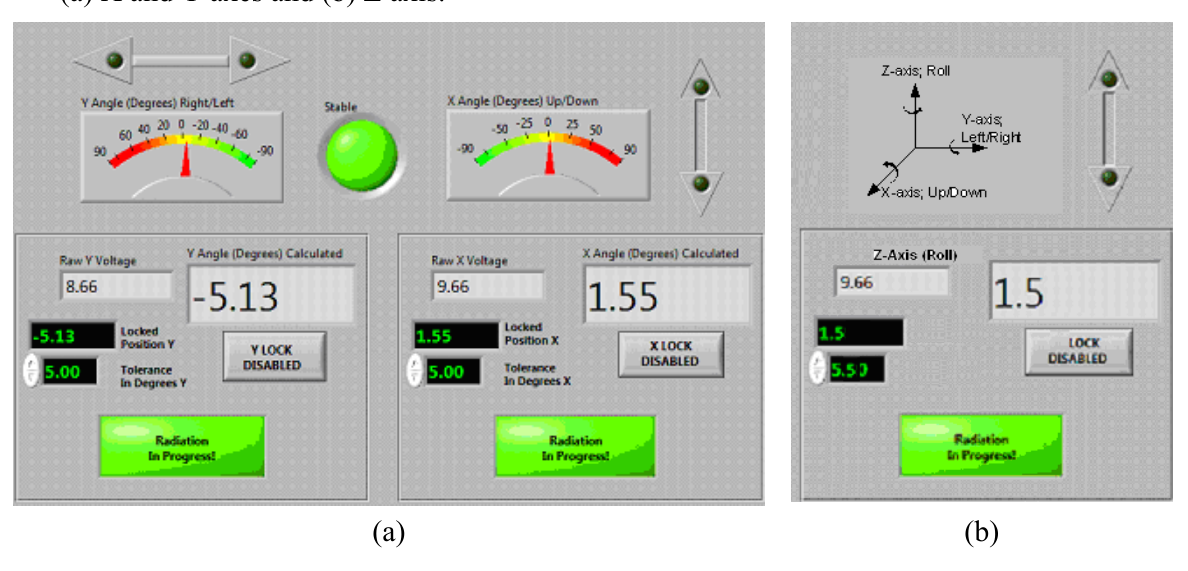
Figure 5. Control panel of APOMS using LabVIEW platform monitoring rotations about (a) X and Y axes and (b) Z